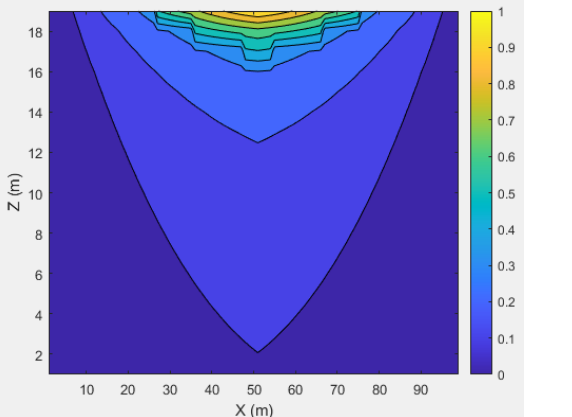
Figure 4. MCTDIs within the workspace: ( a )  50